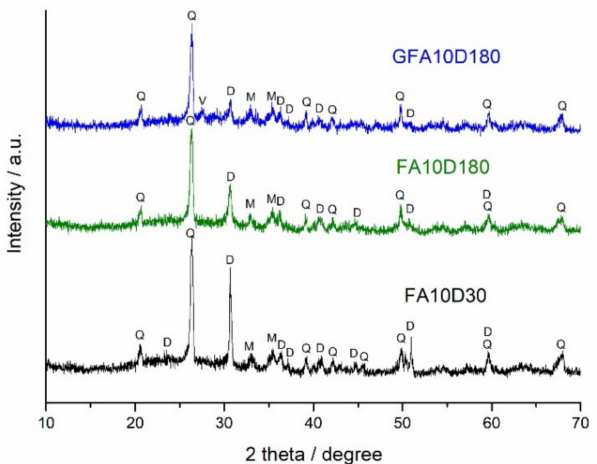
Figure 2. The XRD patterns of the 90% FA + 10% dolomite blend milled for 30 s and 180 s (FA10D30 and FA10D180, respectively) and of the geopolymer synthesized using the FA10D180 blend after 360 d of curing (GFA10B180). Phases marked are Q—quartz (ICDD 00-046-1045), M—mullite (ICDD 00-015-0776), D—dolomite (ICDD 00-036-0426), and V—vaterite (ICDD